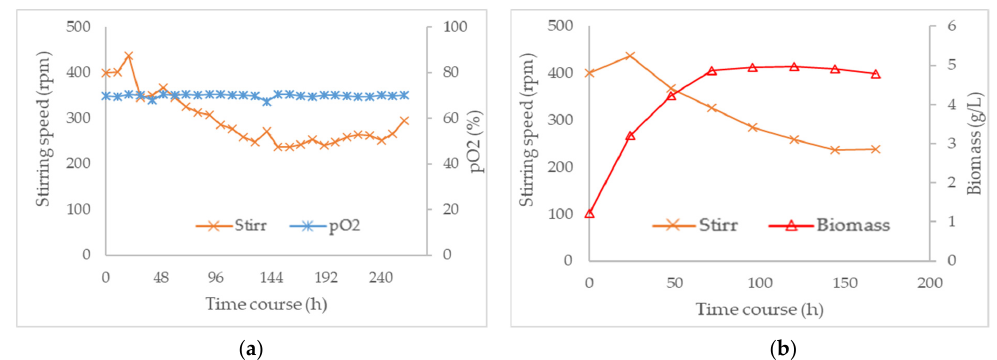
Figure 5. ( a ) Maintenance of dissolved oxygen at 70% over time (0 to 168 h) in a submerged culture of T. albobiverticillius 30548 in a 2 L bioreactor showing the variation of stirring speed over time (0 to 160 h); ( b ) effect of agitation speed over time (0 to 160 h) on biomass production in a submerged culture of T. albobiverticillius 30548 in a 2 L bioreactor in combination with dissolved oxygen at 70%.